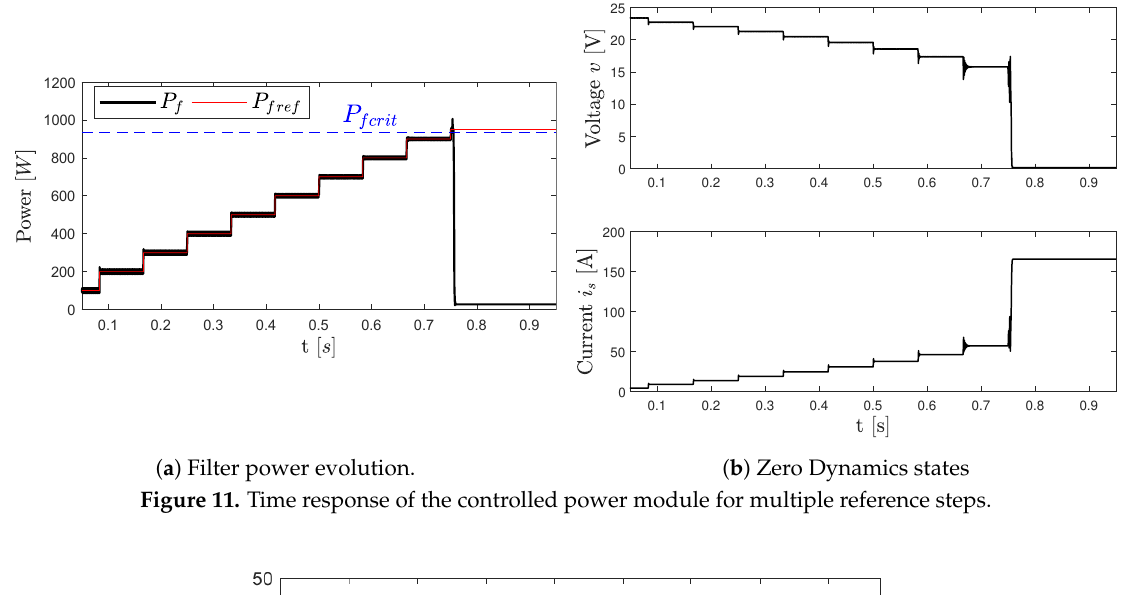
Figure 11. Time response of the controlled power module for multiple reference steps.